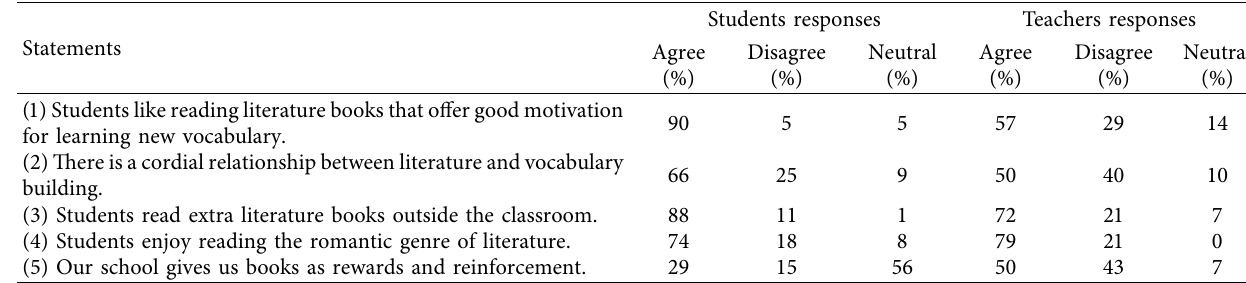
Table 3: Summary of subjects’ responses to students’